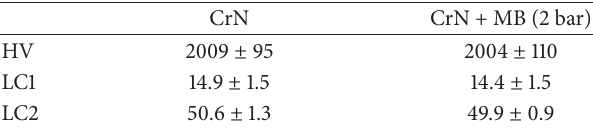
3.2. Morphological Analysis of the Coatings. In Figure 2, the Table 2: Hardness and scratch tests